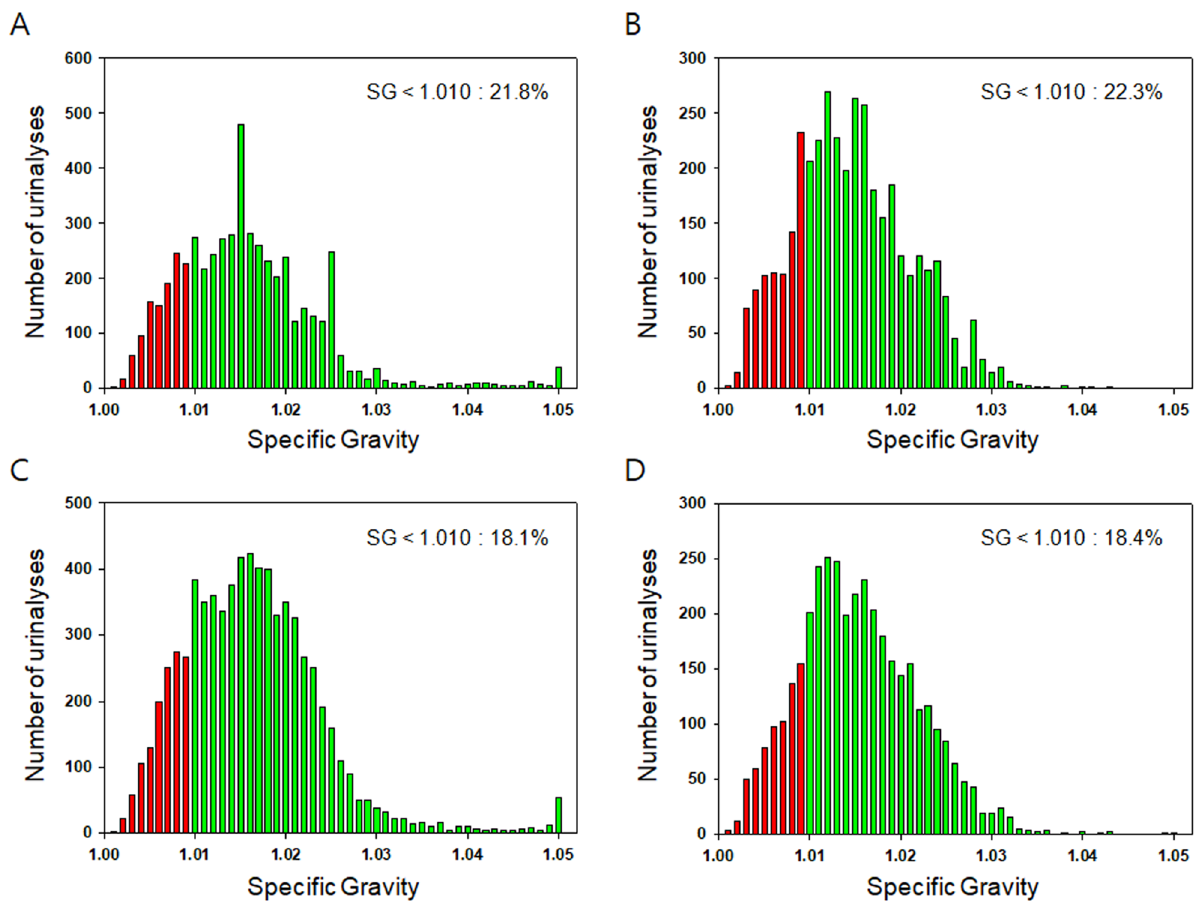
Figure 1. Specific gravities (SG) of urine specimens measured using the UF-1000i urine analyzer (( A ) bladder cancer; ( B ) glomerular disease) and the Cobas 6500 urine analyzer (( C ) bladder cancer; ( D ) glomerular